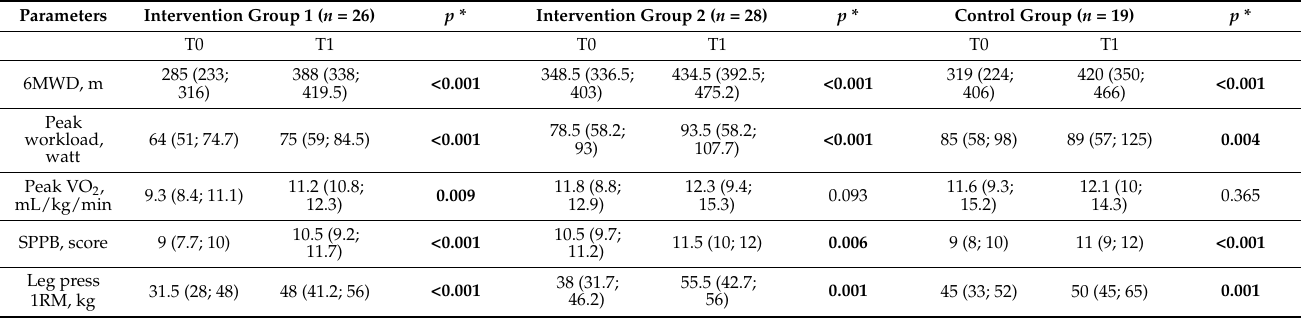
Table 2. Effectiveness of cardiac rehabilitation in the groups, evaluating functional capacity and muscle strength.